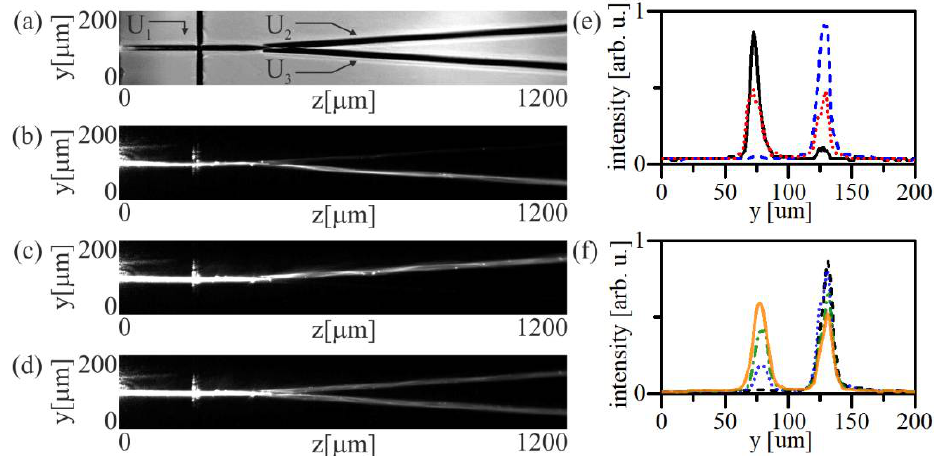
Figure 6. Electro-optic structure with three independent electrodes (with a width of 10 μm each) that forms an optical Y-junction for TM-polarized beam: ( a ) Photo of the designed structure illuminated by white light. ( b – d ) Beam propagation at λ = 1064 nm and ( e ) intensity cross-sections along the y -axis at z = 800 μm that corresponds to biasing voltage of 2.1 V applied to the electrodes: no. 1 and 3 (solid black line), no. 1 and 2 (dashed blue line) and no. 1, 2 and 3 (dotted red line), respectively. ( f ) Intensity cross-sections along the y -axis at z = 800 μm in case of biasing voltage of 2.1 V applied to electrodes 1 and 2, as a function of voltage at electrode no. 3: 0 V (dashed black line), 1.0 V (dotted blue line), 1.4 V (dash-dotted green line), 2.1 V (solid orange line).